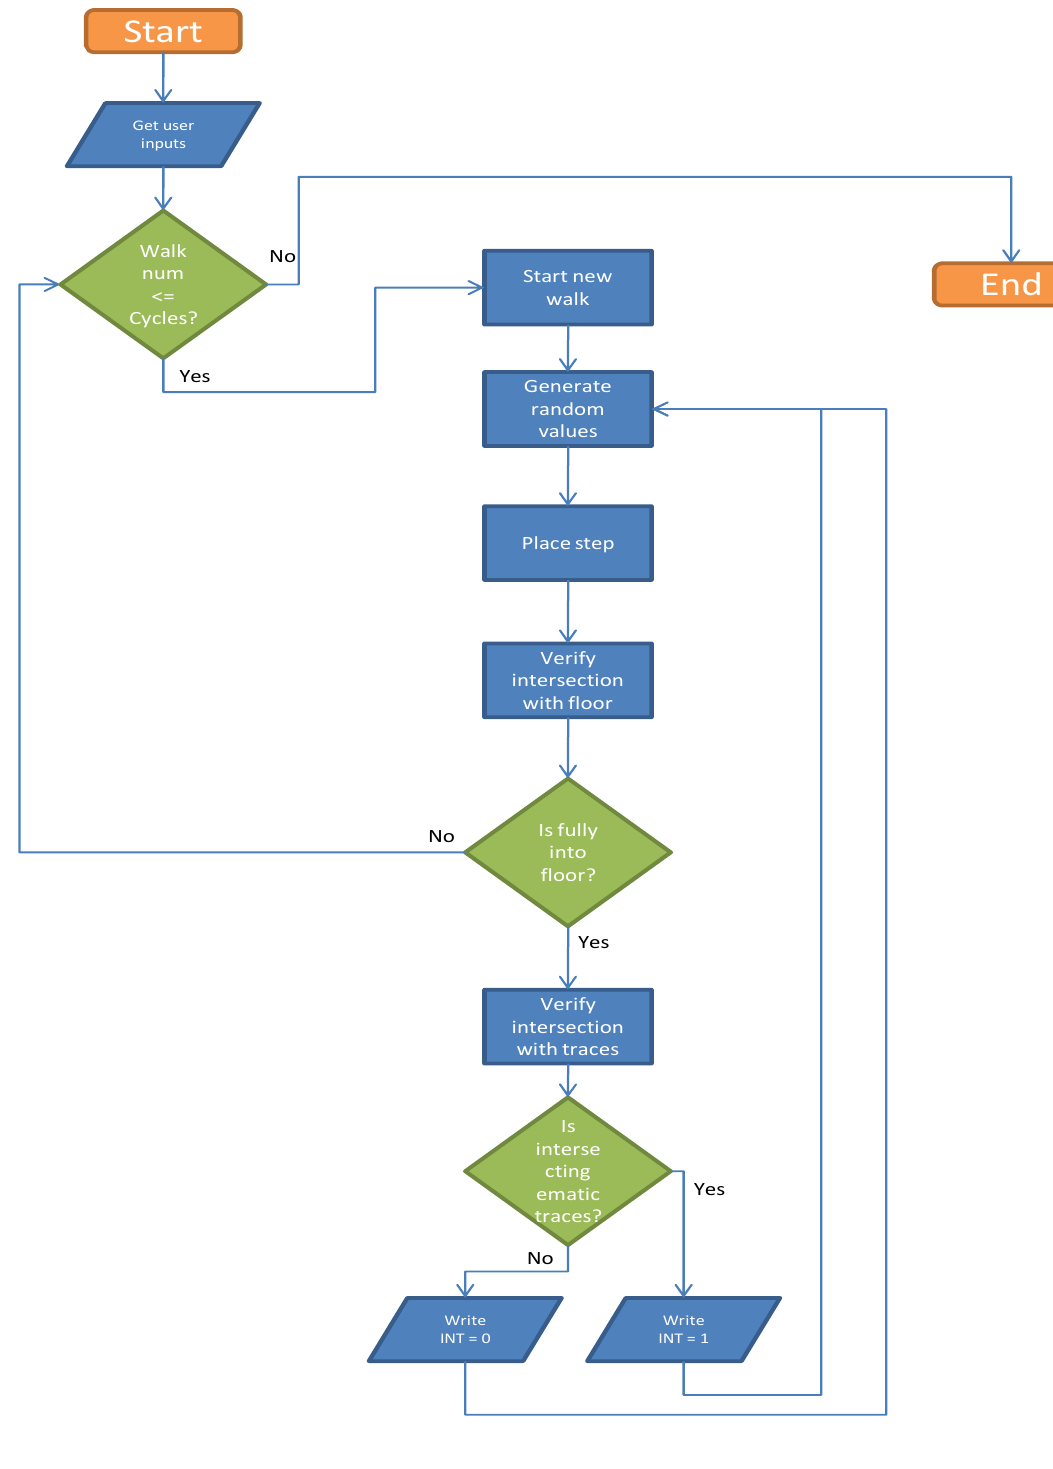
Figure 12. Schematic procedure workflow